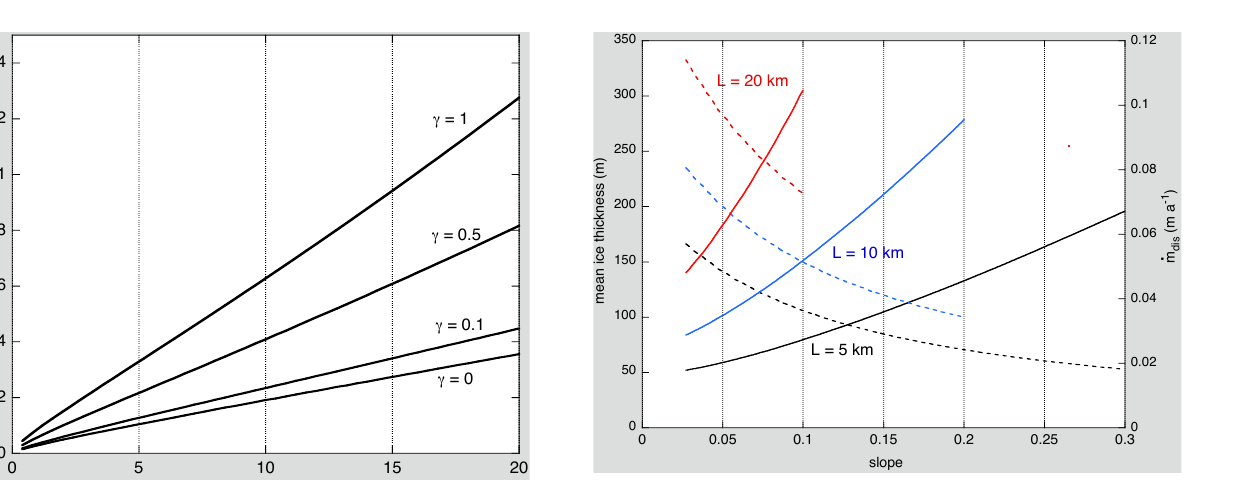
Fig. 4. Ice thickness (dashed, scale at left) and dissipative melt rate (solid lines, scale at right) as a function of bed slope, for three values of the glacier length as indicated in the figure.